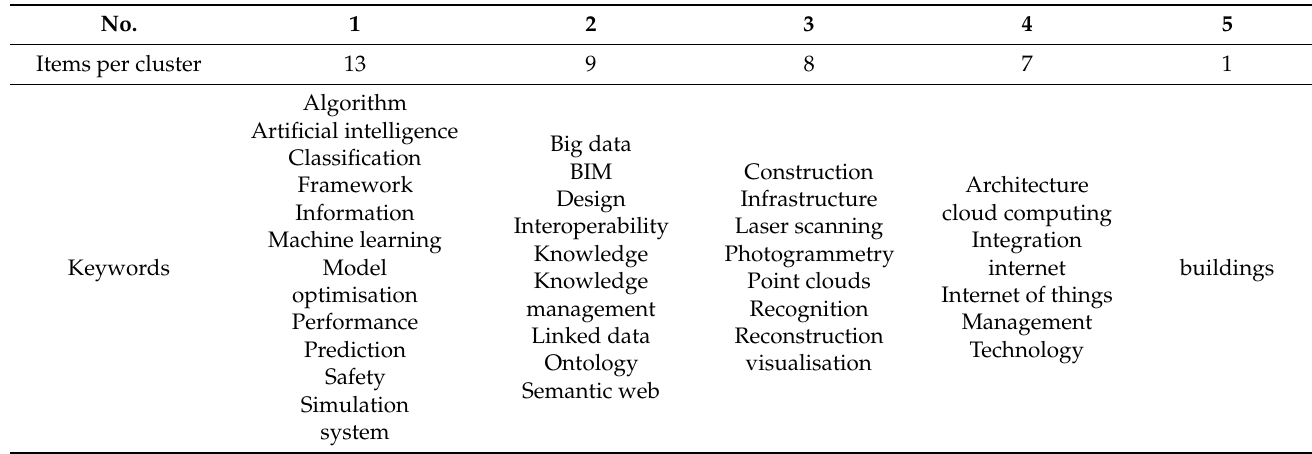
Table 2. Clusters classification based on VOSViewer ®